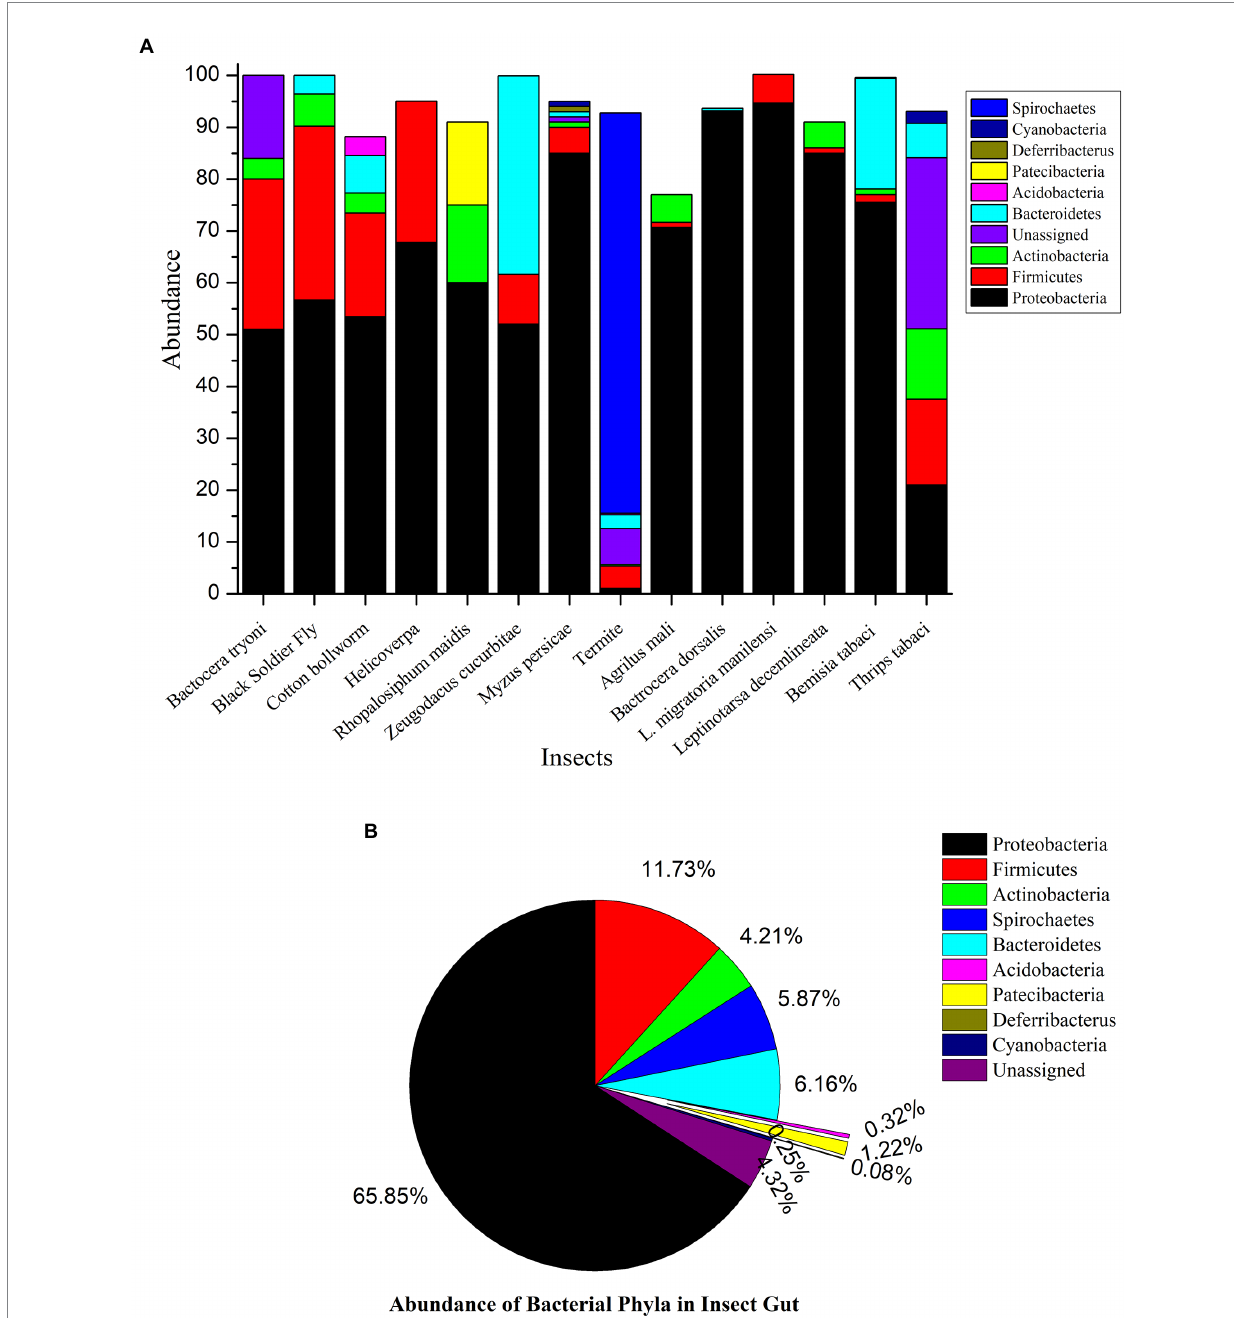
FIGURE 1 (A) Metagenomics study of various insect pests. 16s rRNA based metagenomics studies reveal that insect gut is resided by number of bacterial genera. (B) Microbial Diversity and abundance in the various insect pests. This figure illustrates the dominance of Proteobacteria among the other